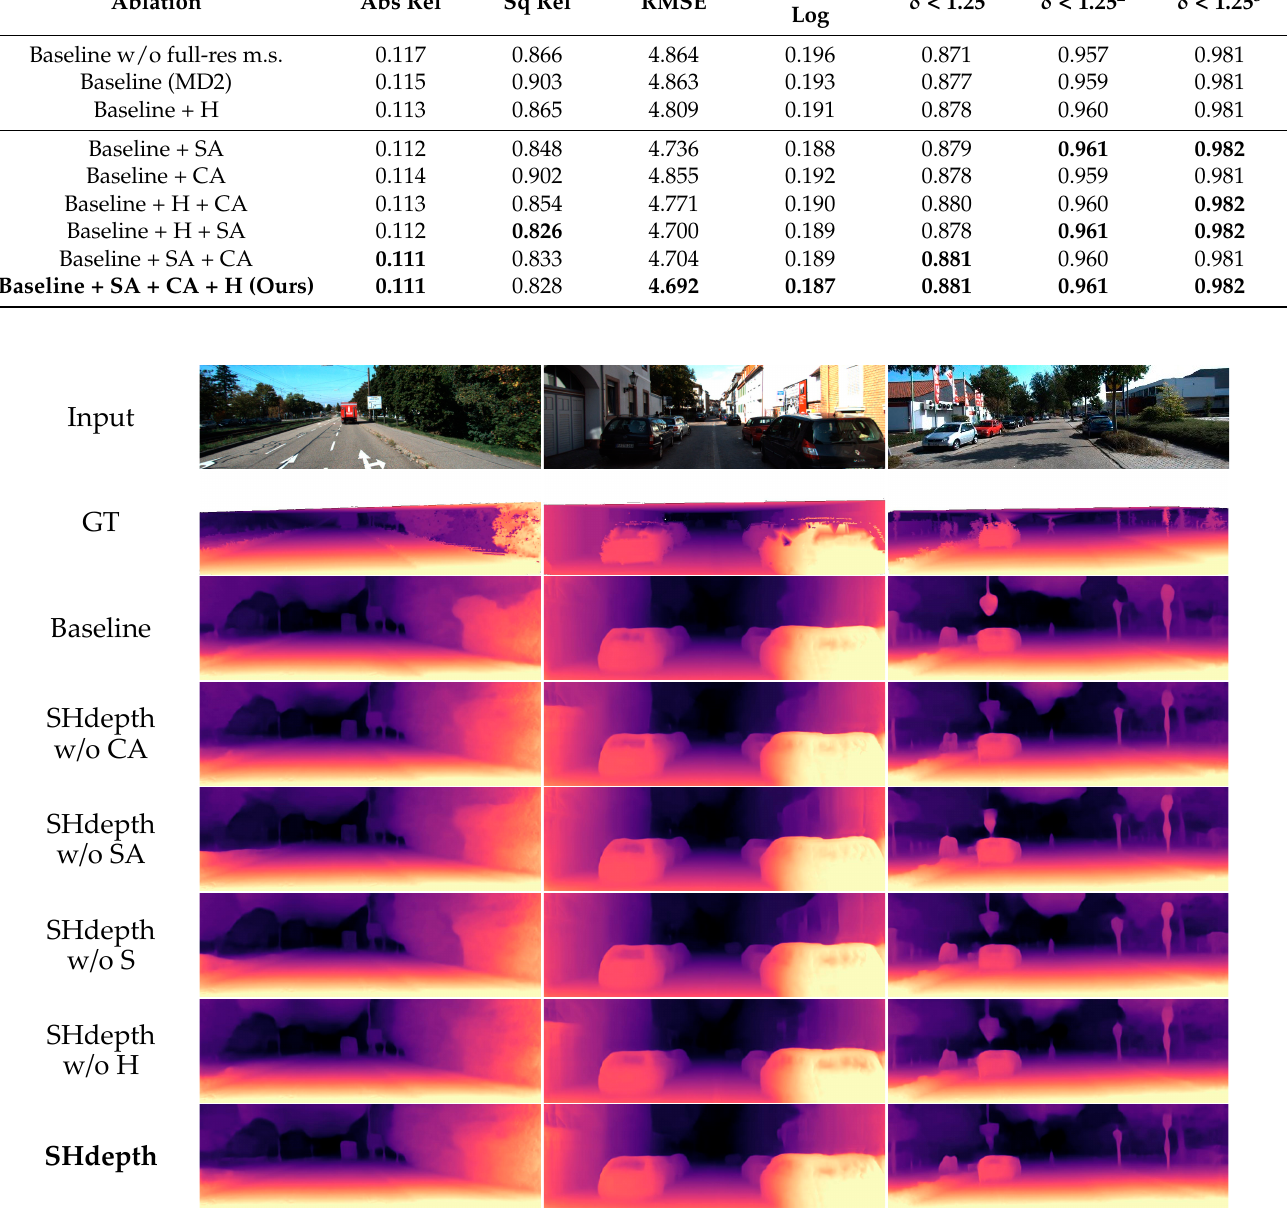
Figure 7. Qualitative ablation study on the KITTI eigentest split. CA (row 4) is channel attention and SA (row 5) is spatial attention. S (row 6) is the soft attention module and H (row 7) is the hard attention strategy in our SHdepth.